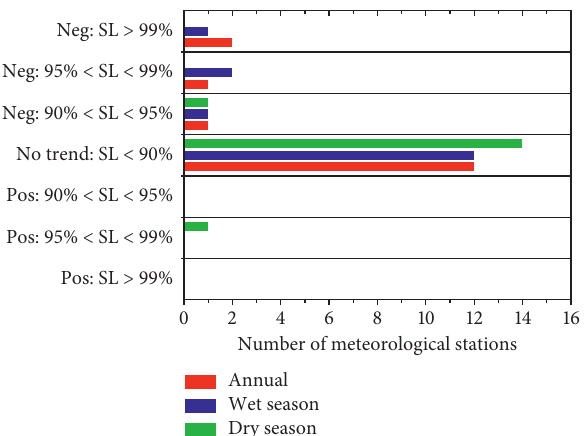
Figure 6: Observed CI trends for different ranges of the significance